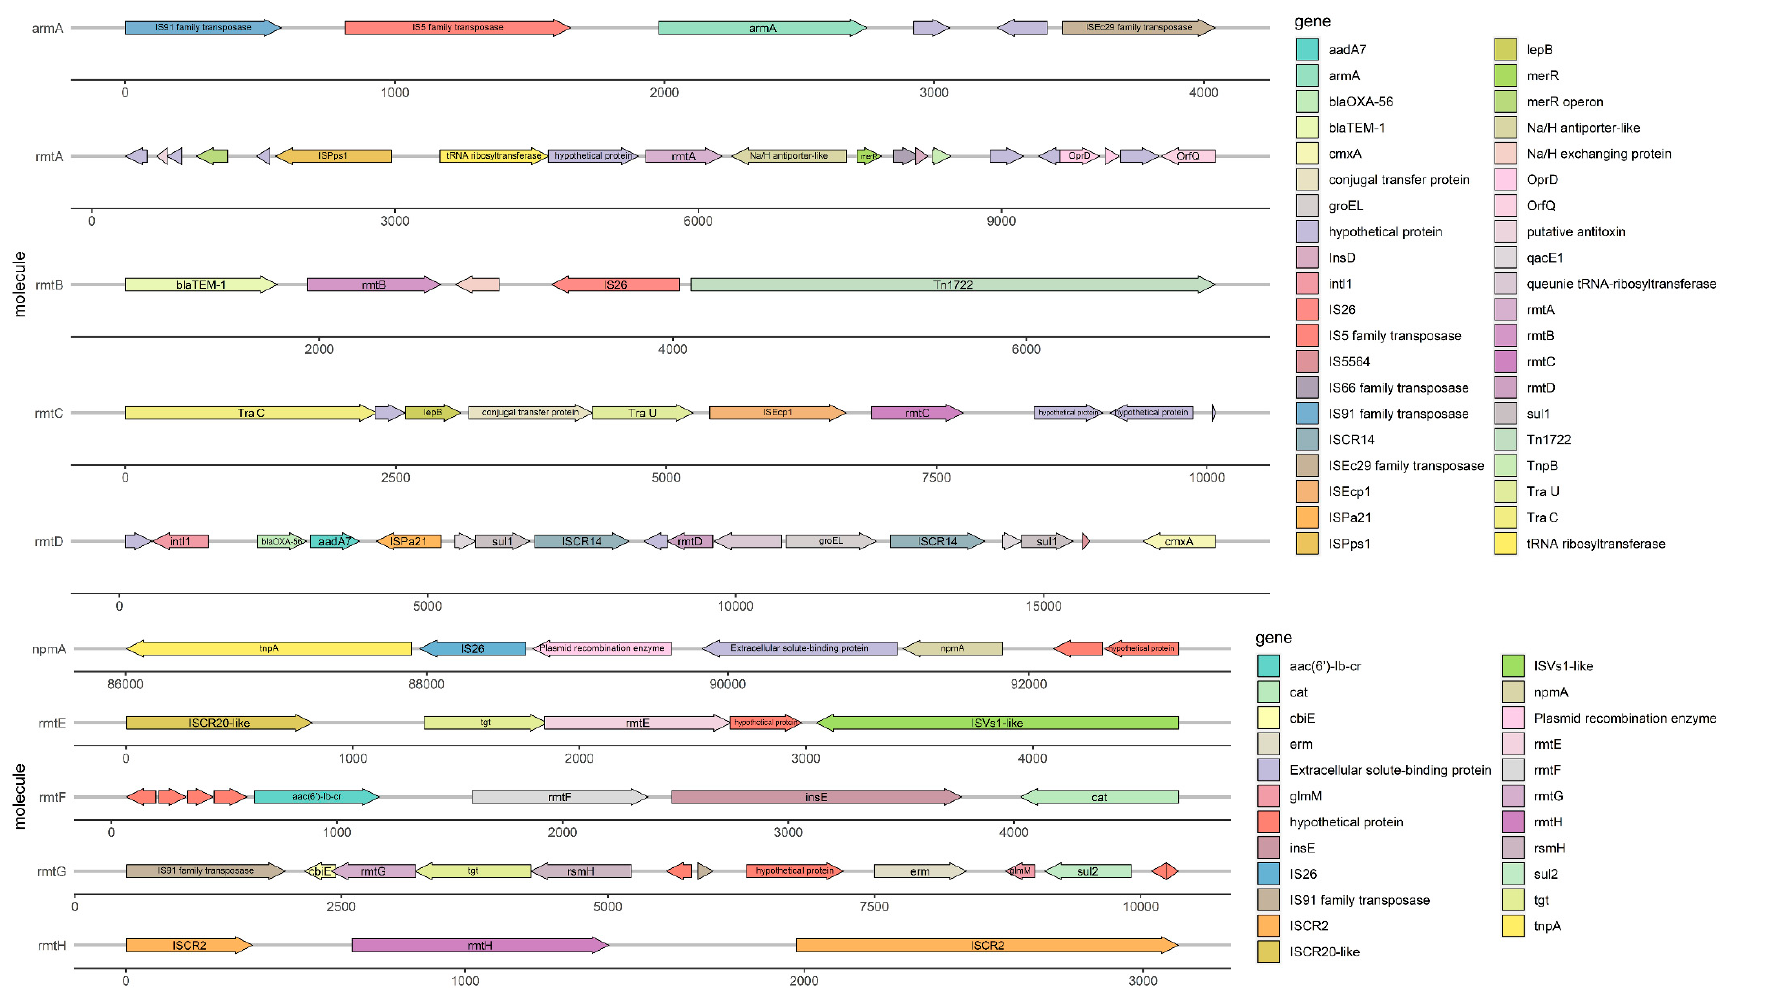
Figure 2. The sequence of the 16S rRNA methylase resistance gene and its genetic environment. GenBank: rmtA , AB083212.2; rmtB , FJ556899.1; rmtC , AB194779.2; rmtD , DQ914960.2; rmtE , KT428293.1; rmtF , JQ808129.1; rmtG , VLNW01000106.1; rmtH , KC544262.1; armA , AY220558.1; npmA , AB261016.2.